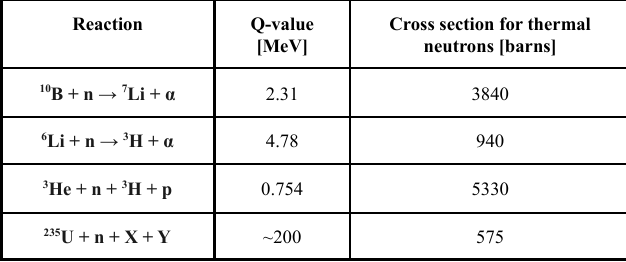
Table 1. Reactions of interest involving neutron capture, the released energy (Q-value) and their cross-section for thermal neutrons are shown, where n represents a neutron, p a proton, α an alpha particle and X/Y the fission